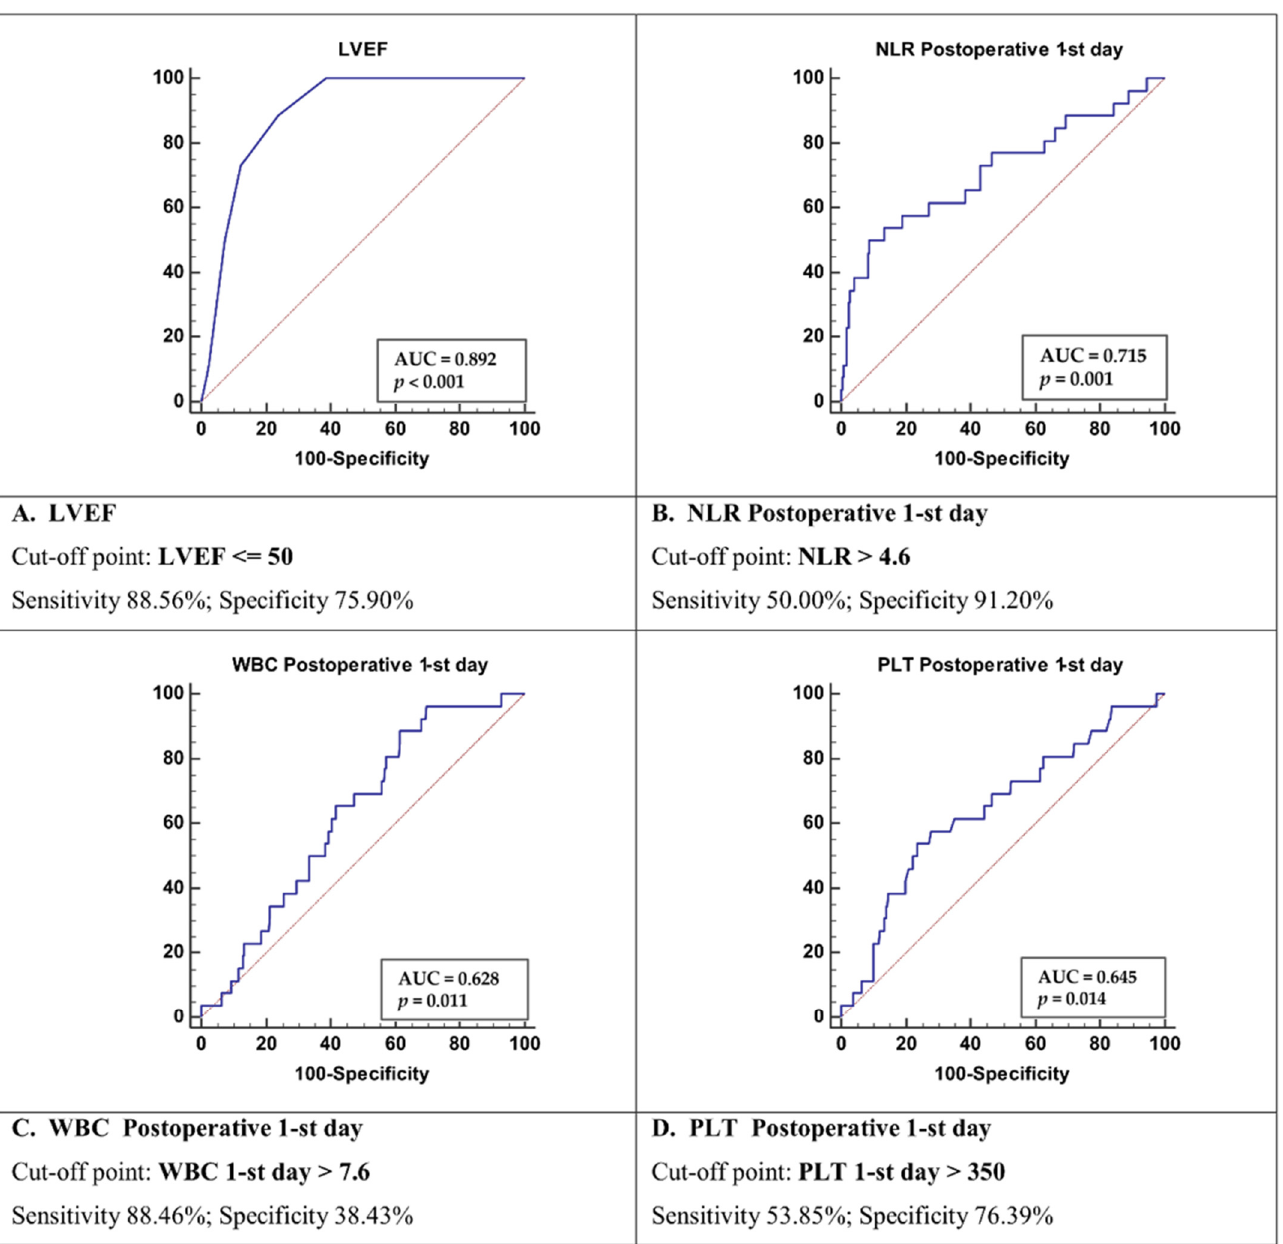
Figure 2. Receiver operating characteristic curves for Cox’s model LVEF ( A ). NLR on first postoperative day ( B ). WBC on first postoperative day ( C ). PLT on first postoperative day ( D ). Abbreviations: LVEF—left ventricle ejection fraction,